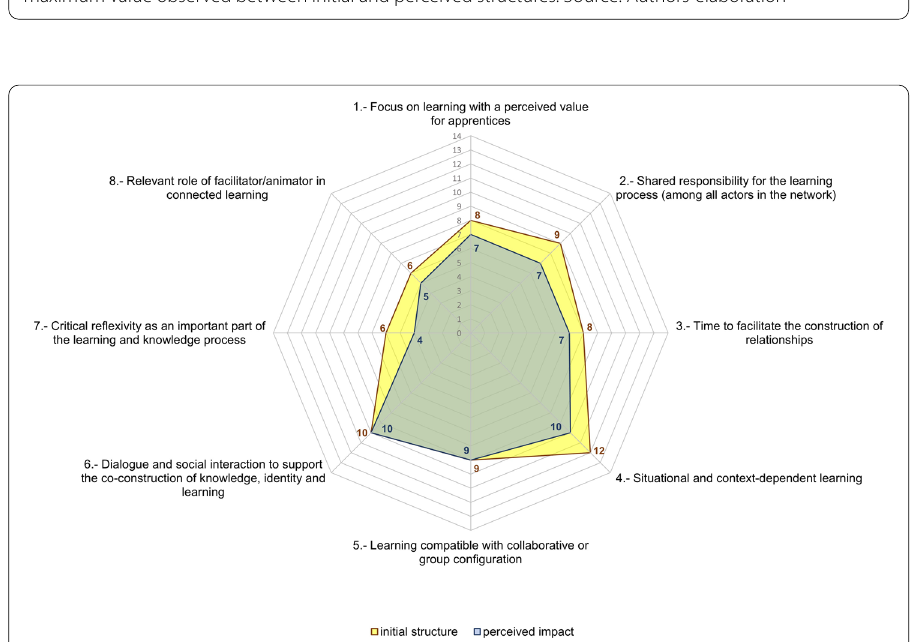
Fig. 7 NLP differences between perception results and initial structure on D4. The scale represents the maximum value observed between initial and perceived structures. Source: Authors’